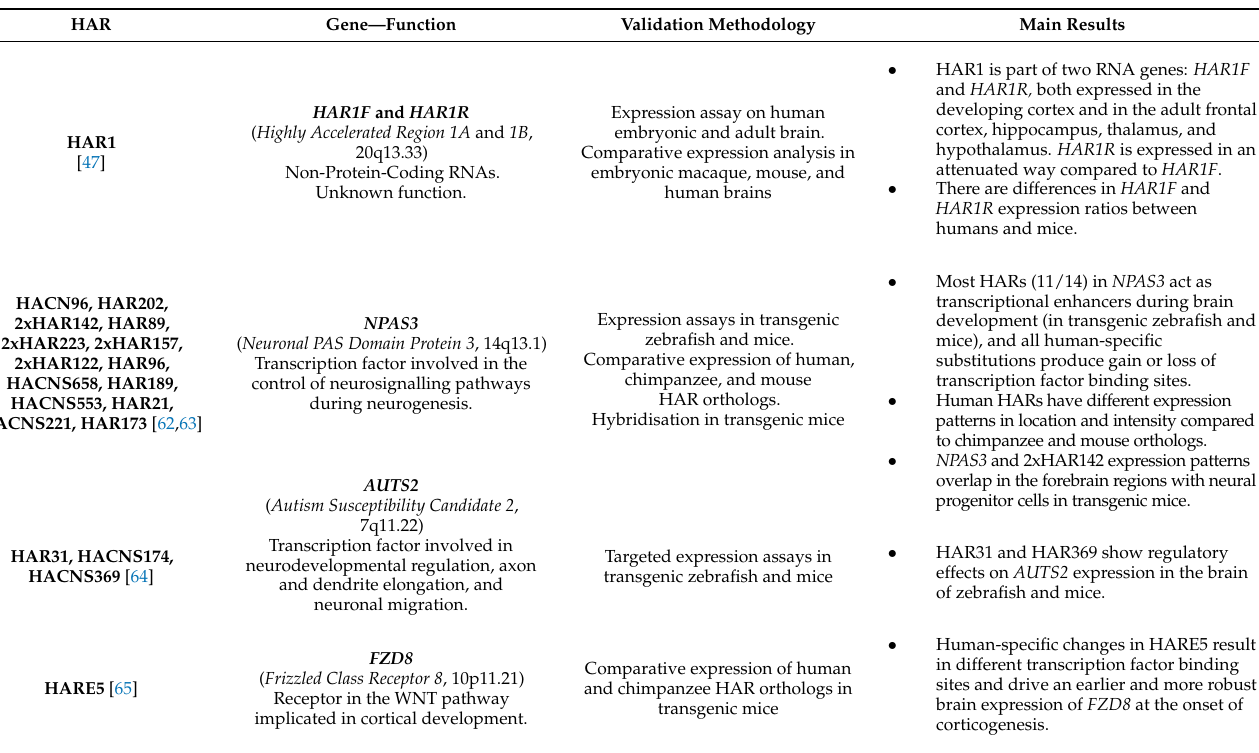
Table 2. Summarised results of the functional validation of HAR regulatory activity on candidate